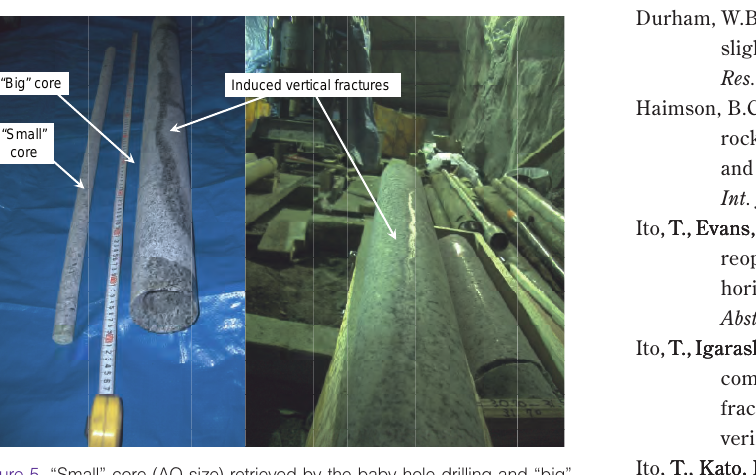
Figure 5. “Small” core (AQ size) retrieved by the baby hole drilling and “big” core (PQ size) retrieved by the over-coring. Hydraulically-induced fractures appeared in the big